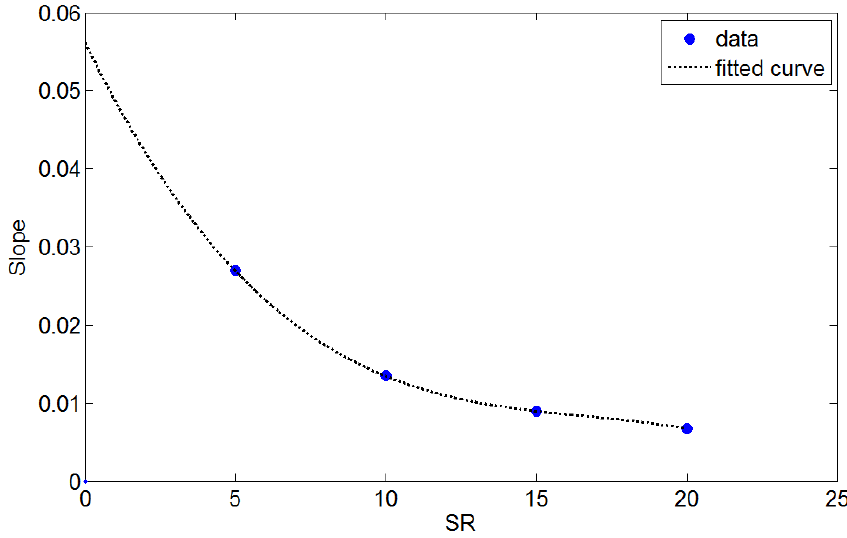
Figure 5. The slopes of the trend lines in Figure 4 are plotted as a function of SR